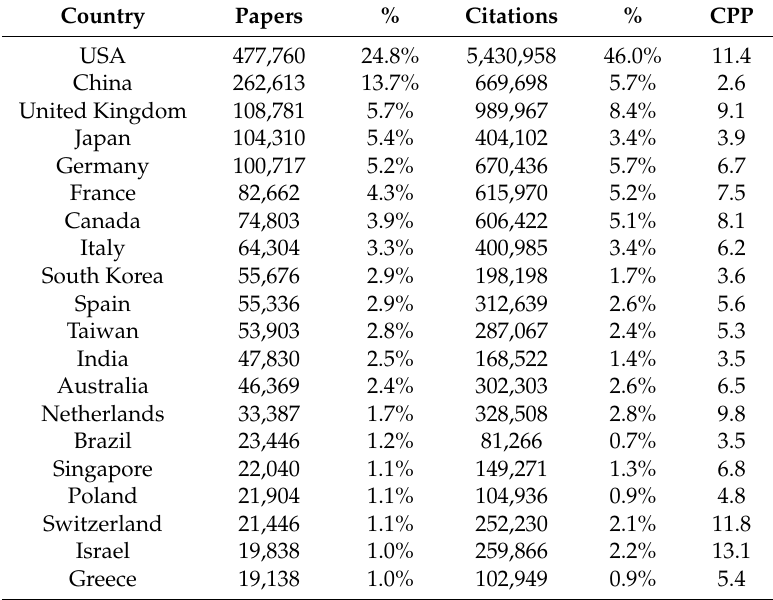
Table 4. Top 20 countries and their papers, citations, and citations per paper